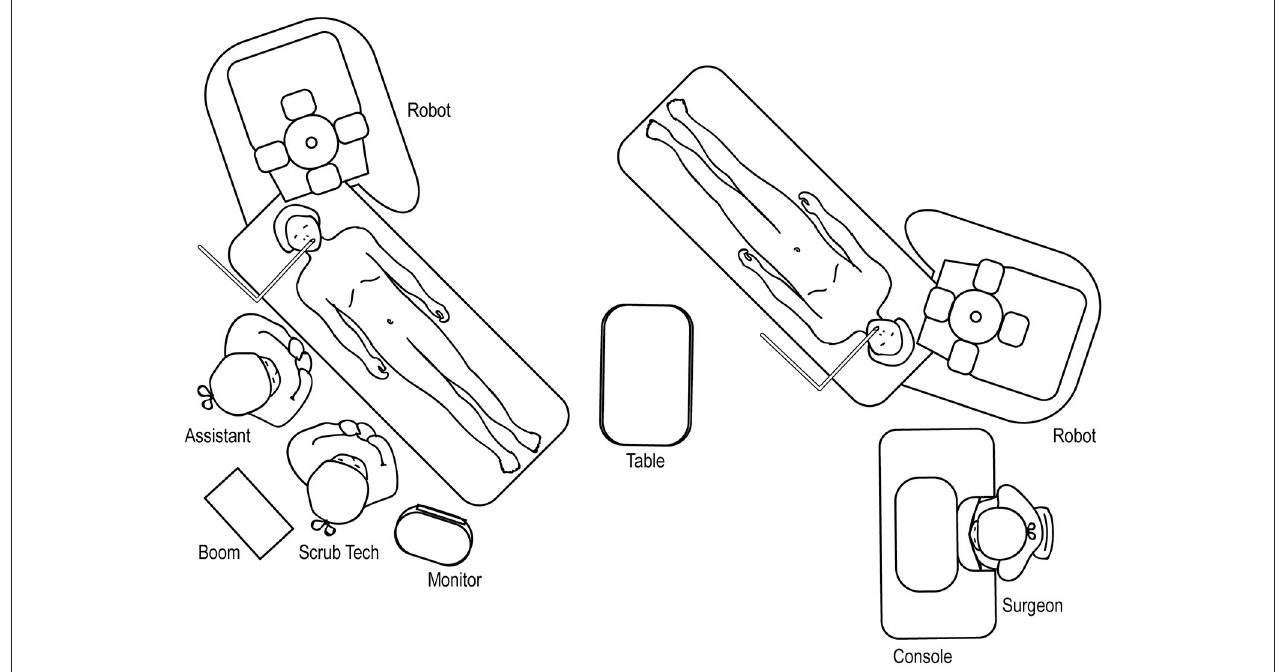
FIGURE 13 | Overhead view of room set-up for upper urinary tract hidden incision endoscopic surgery (HIdES), with robot docked at ipsilateral shoulder.